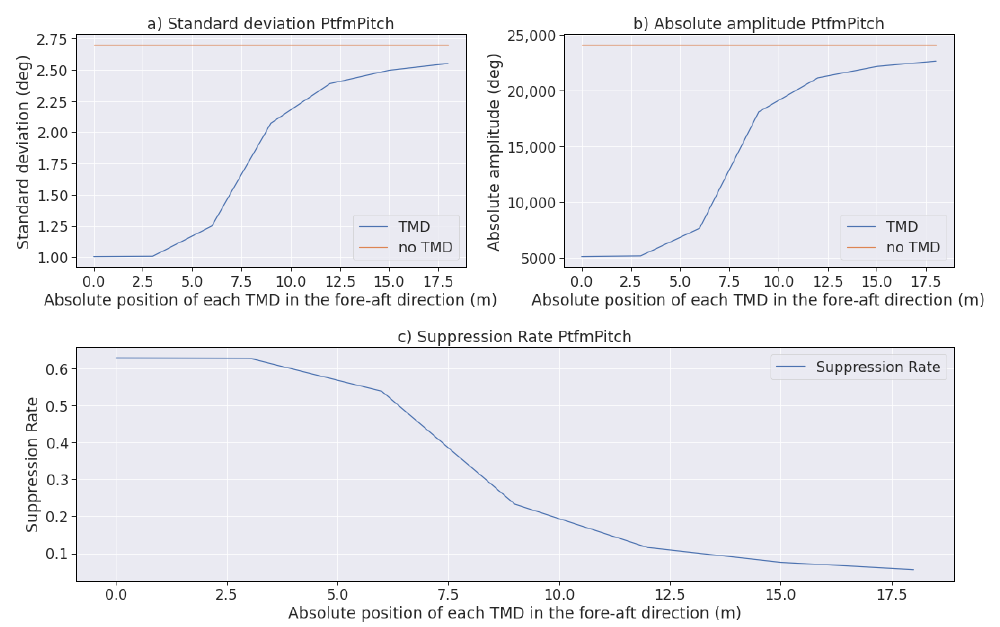
Figure 10. The results when moving two TMDs in the fore-aft direction keeping the same distance to the center. ( a ) Sum of PtfmPitch standard deviation; ( b ) Sum of PtfmPitch amplitude; and, ( c ) PtfmPitch suppression rate. Figure 11 shows the TTDspFA (left) and the variable PtfmPitch (right) with two TMDs placed at 3 m from the tower in the fore–aft direction (blue lines) and without TMD (orange line). These results confirm the suppression rate obtained before. That is, the oscillation is greatly